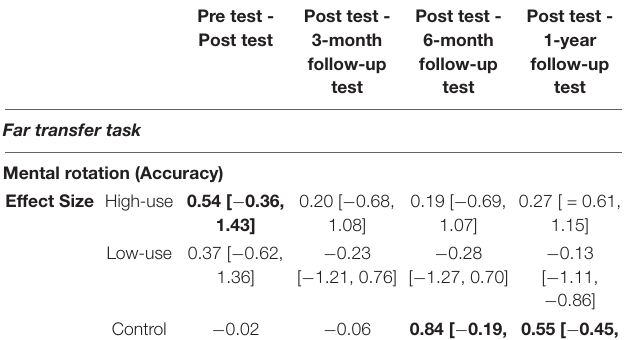
TABLE 9 | ANOVA analysis and effect sizes of far transfer mental rotation task in Experiment